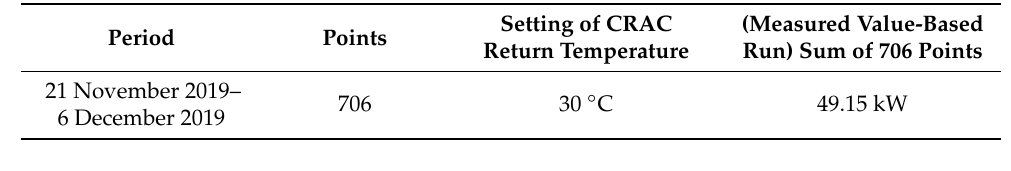
Table 24. Energy-saving effect when return temperature of the CRAC is set to 30 °C (21 November